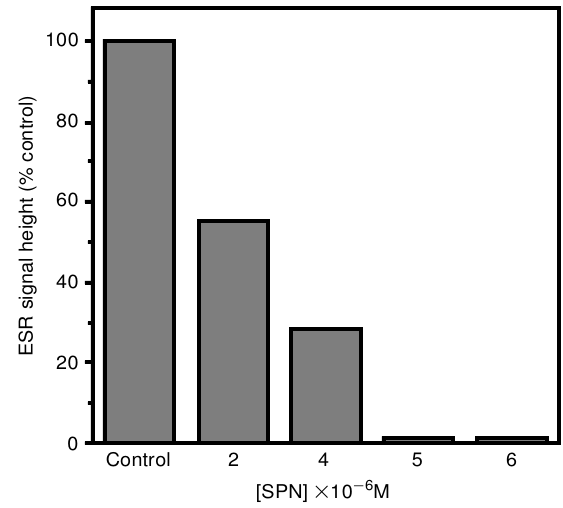
FIG. 2. Effect of increasing concentrations of sphingosine on ESR signal heights of activated human neutrophils (6 3 10 6 cells / ml). Spin trap (DMPO, 100 mM), activator PMA (5 3 10 - 7